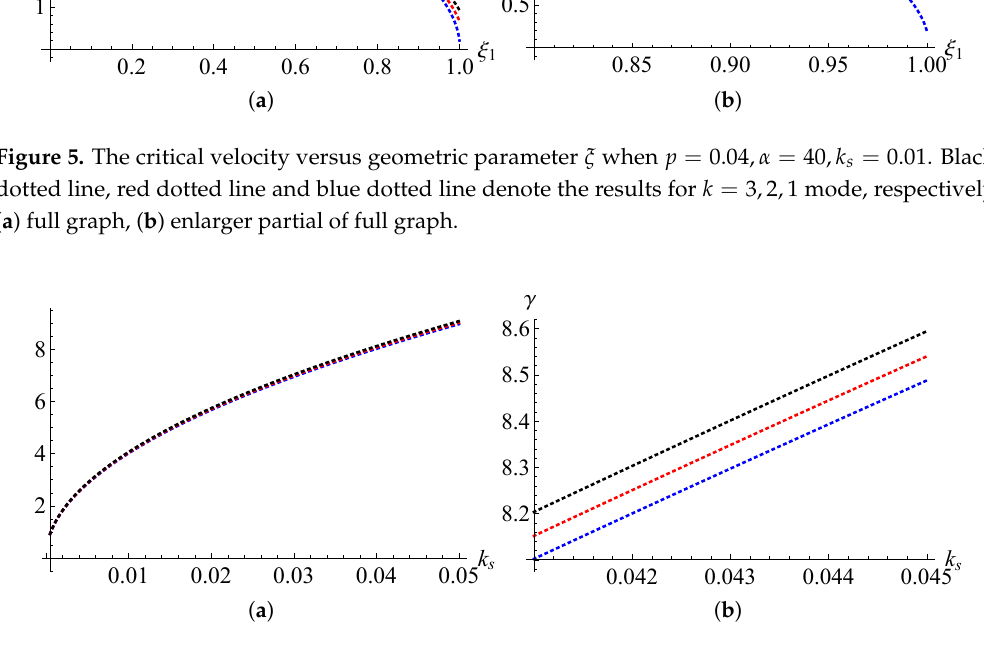
Figure 6. The critical velocity versus geometric parameter k s when p = 0.04, α = 40, ξ 1 = 0.5. Black dotted line, red dotted line and blue dotted line denote the results for k = 3,2,1 mode, respectively. ( a ) full graph, ( b ) enlarger partial of full